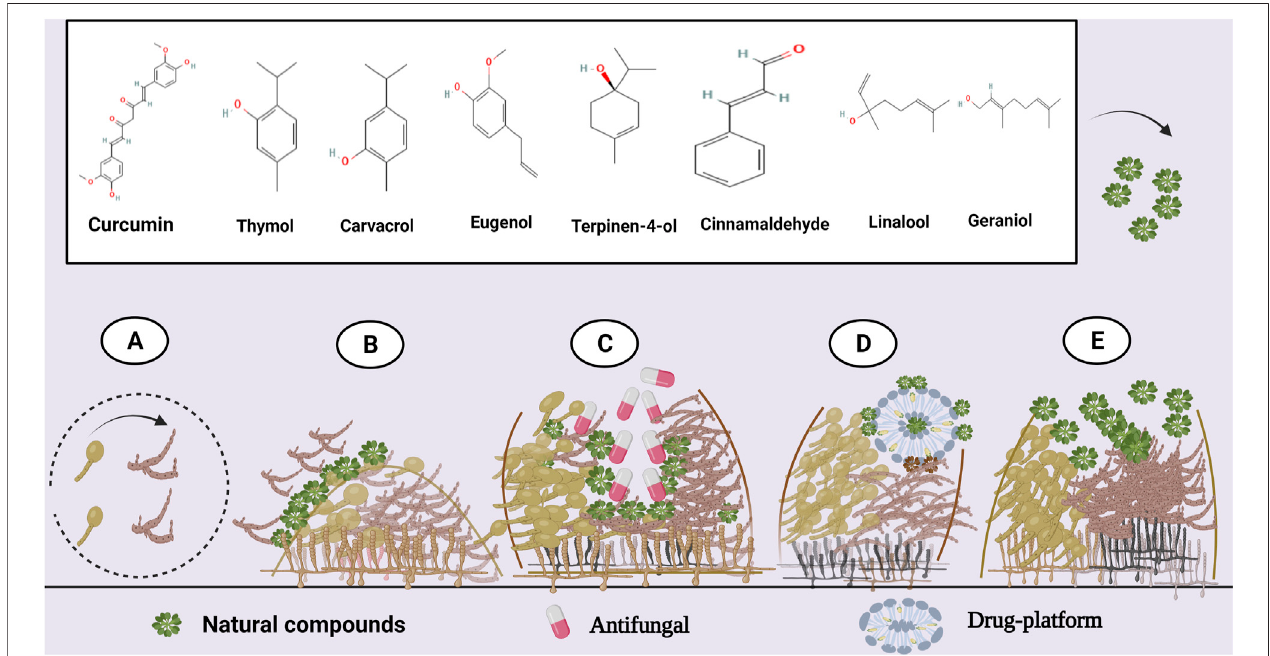
FIGURE 1 | Antibio fi lm activity of various natural compounds against Candida . (A) Inhibition of yeast-to-hypha morphological transition and (B) initial Candida adhesion. (C) Synergistic combination with antifungals. (D) Drug delivery platforms could enhance natural compounds ’ antibio fi lm ef fi cacy. (E) Destruction of an established bio fi lm. Created with